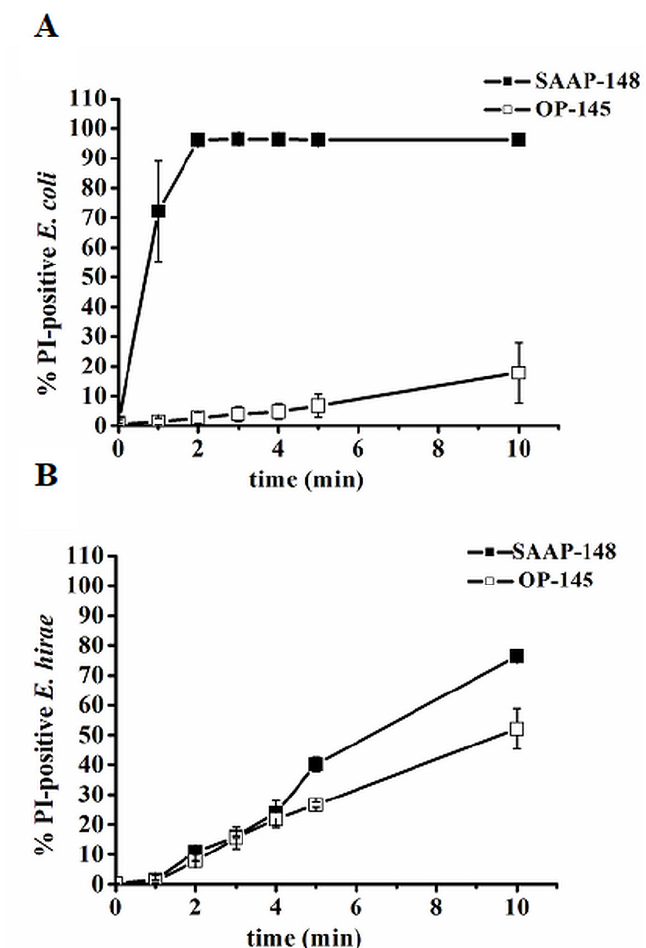
Figure 4. Membrane permeability of E. coli ( A ) and E. hirae ( B ) in absence and presence of OP-145 (empty squares) and SAAP-148 (filled squared) at concentration where they kill 99.9% cells. Data points are averages ± standard deviations of three independent experiments.